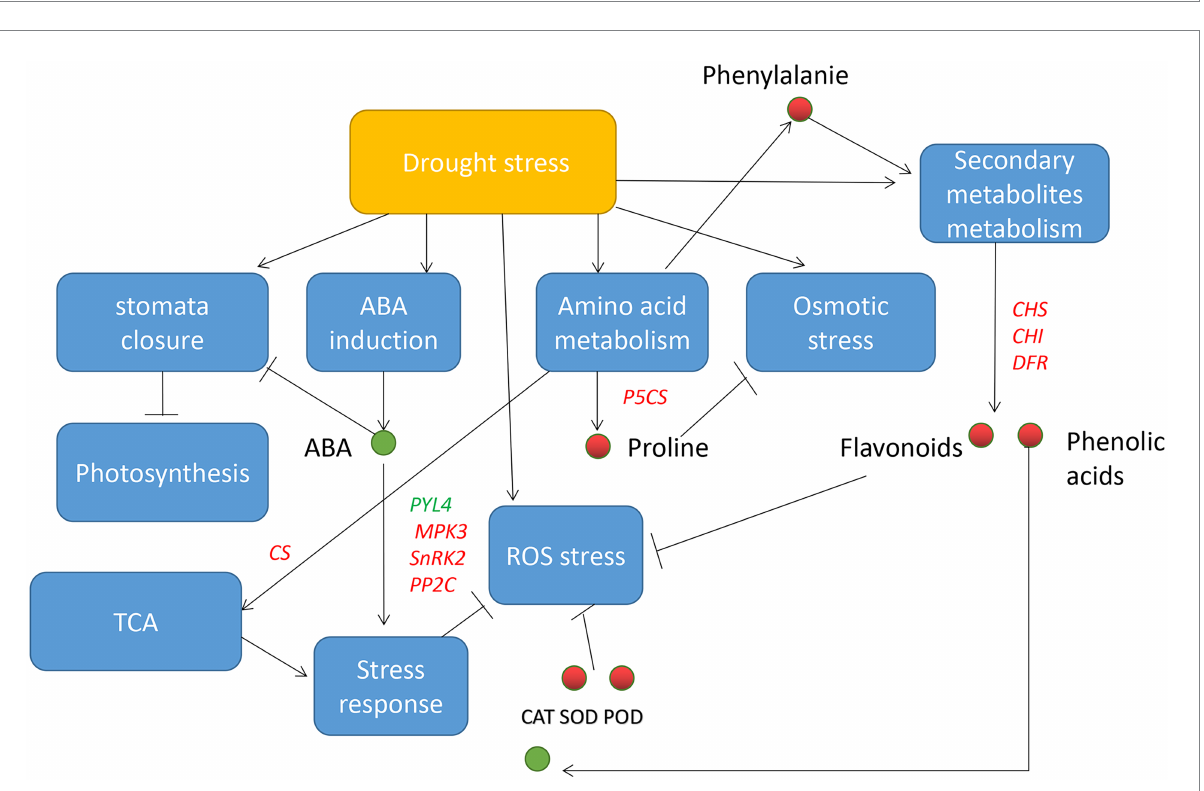
FIGURE 11 Drought tolerance model based on the present study. Blue rectangle indicates biological process, red/green circle indicates increased/decreased substances, red/green words indicates up-/down-regulated genes, line (T) indicates inhibition, and arrows indicates induction.